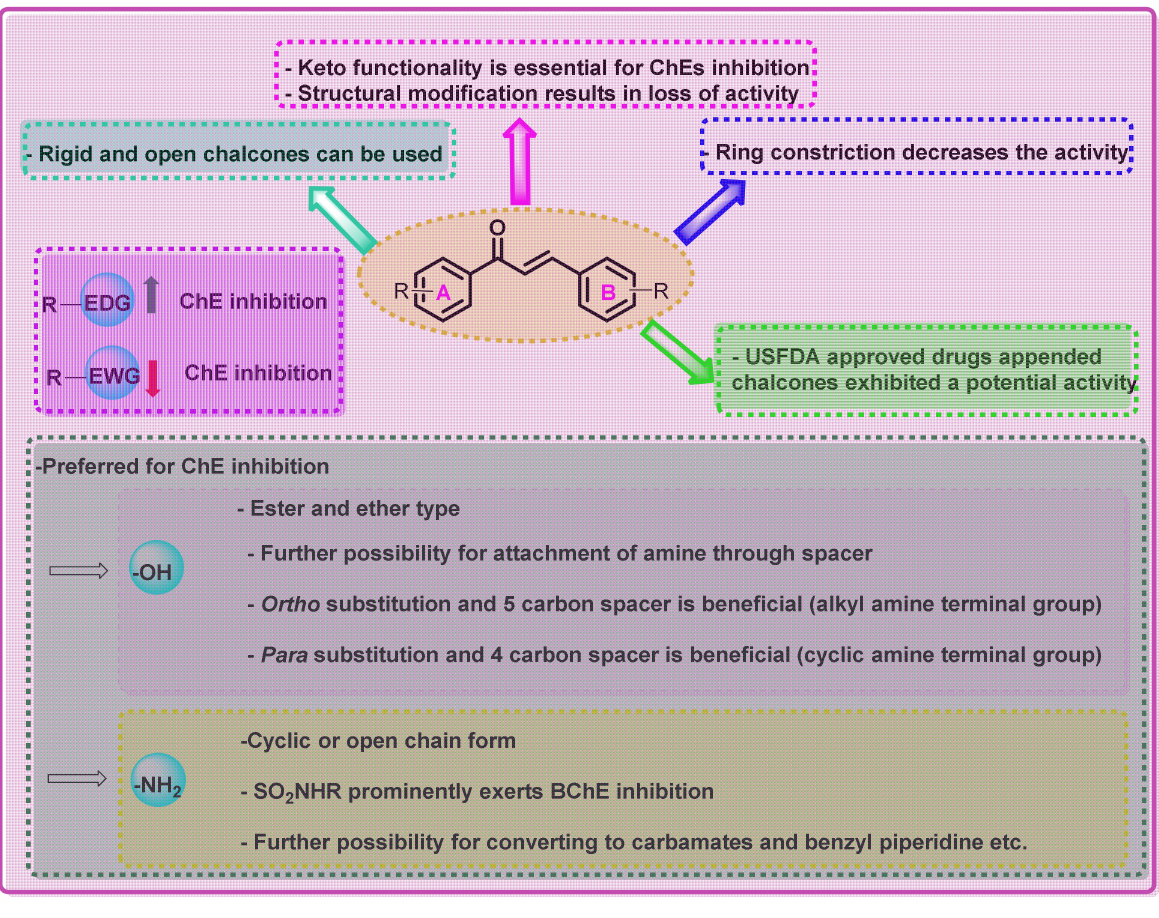
Figure 48. Summary of SAR points in ChE